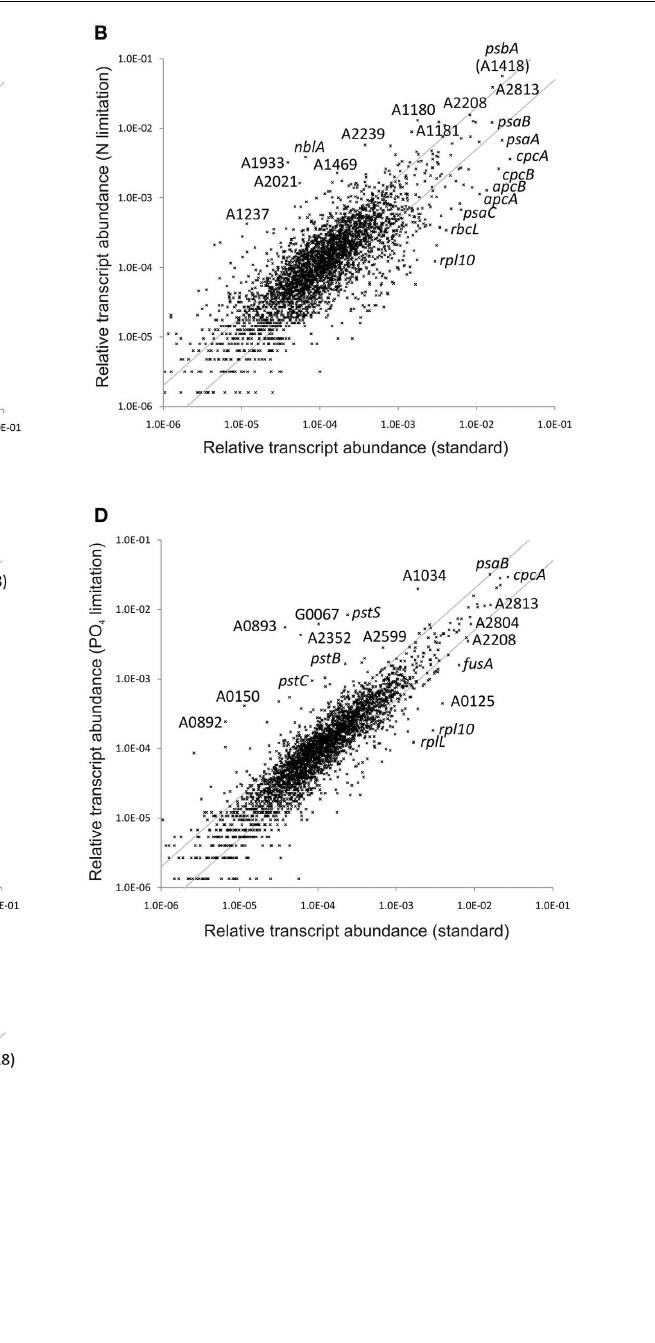
and (E) iron deprivation compared to that for “standard” growth conditions (mean of three biological replicates).The gray lines give 2-fold changes in either direction. Selected genes are identified by name/locus tag